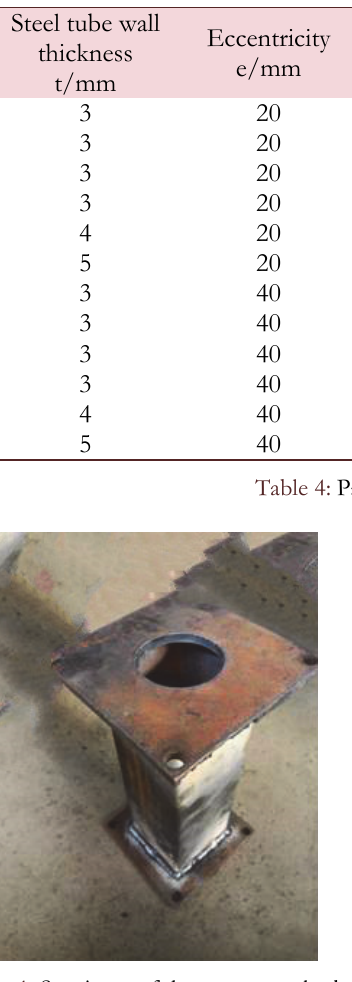
Figure 1: Specimen of the square steel tube. Figure 2: Experimental